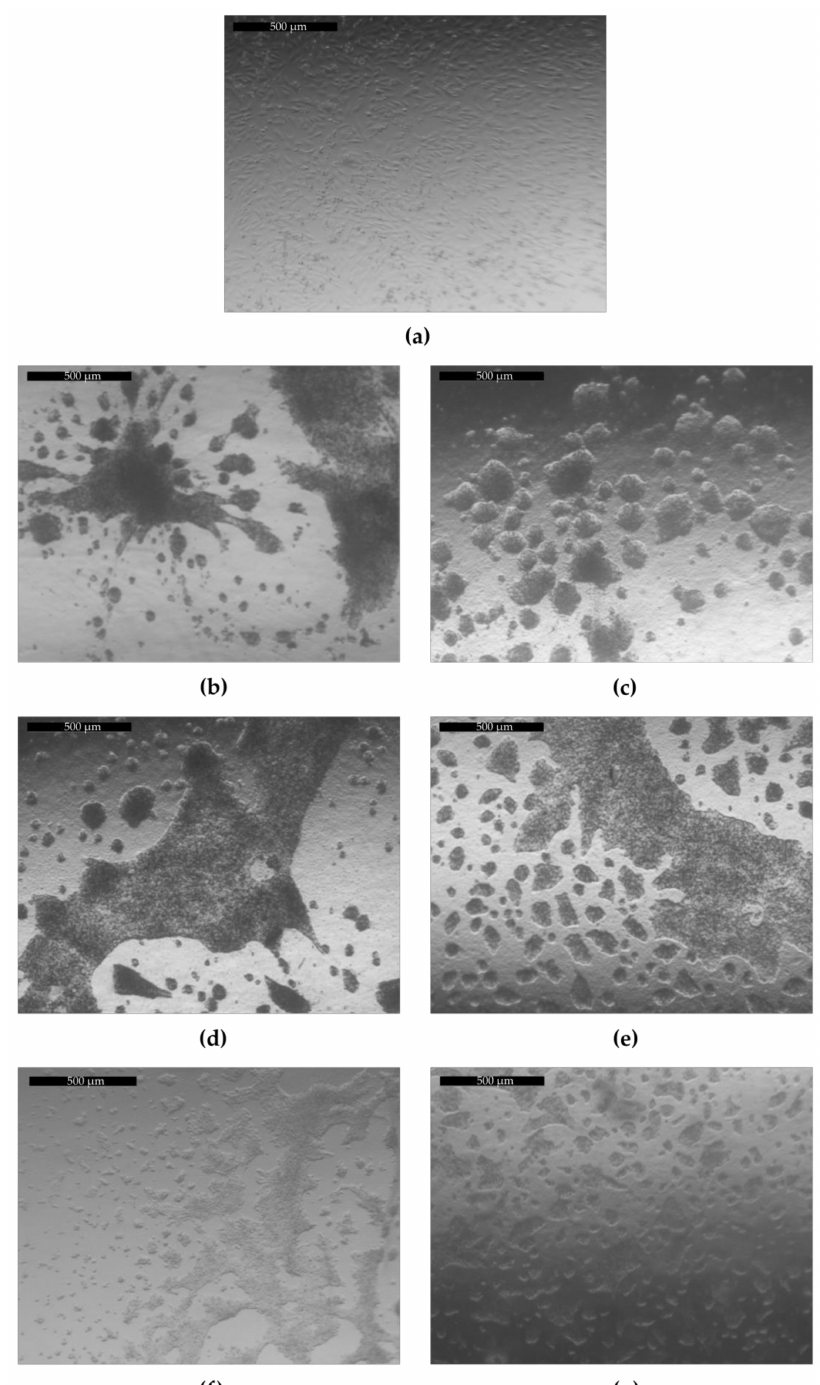
Figure A2. The ATDC5 cell growth morphology after 20 days of incubation on the surface of different scaffolds: ( a ) control growth on plastic, ( b ) growth on pure BNC scaffold, ( c – g ) growth on the surface on BNC/ κ -Car composites: ( c ) BNC/ κ -Car 0.2 , ( d ) BNC/ κ -Car 0.5 , ( e ) BNC/ κ -Car 0.8 , ( f ) BNC/ κ -Car 2.0 , ( g ) BNC/ κ -Car 4.0